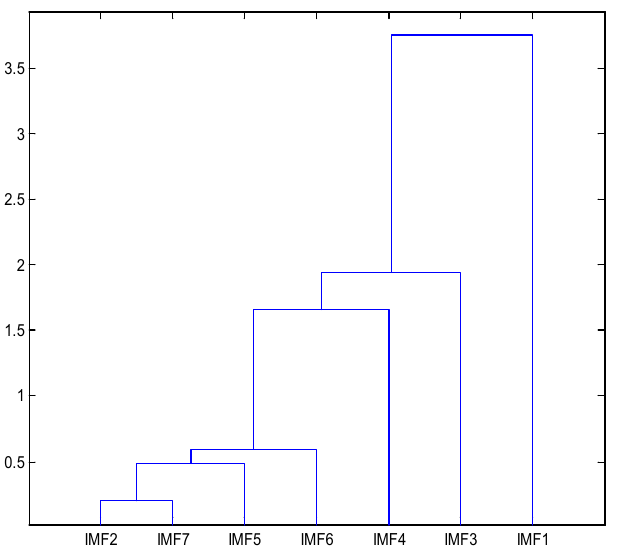
Figure 16. Cluster analysis results of IMF.